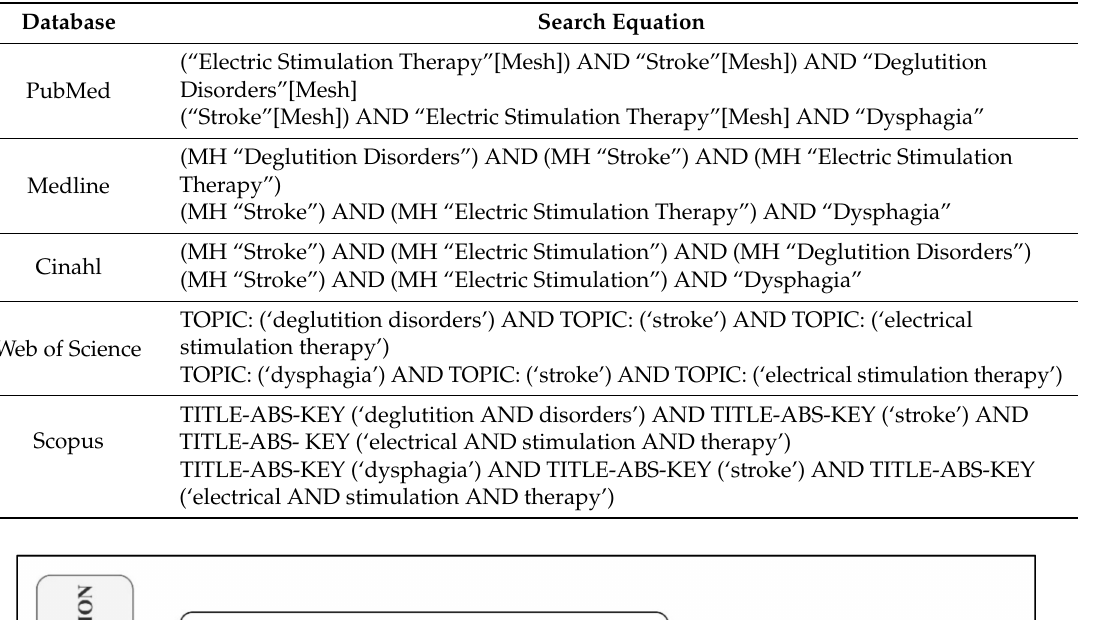
Table 1. Search strategy according to the focused question (PICO).